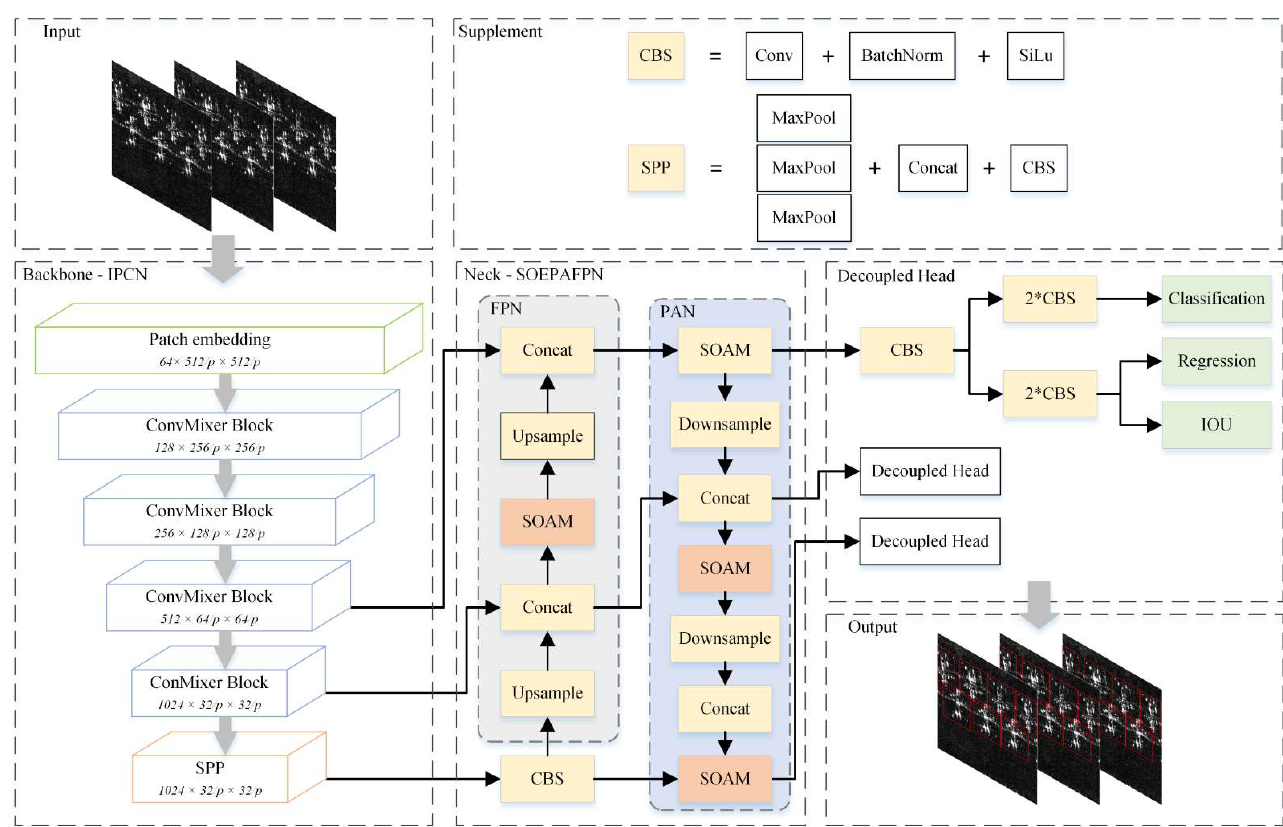
Figure 1. The overall architecture of the spatial orientation attention enhancement network (SOAEN). 146